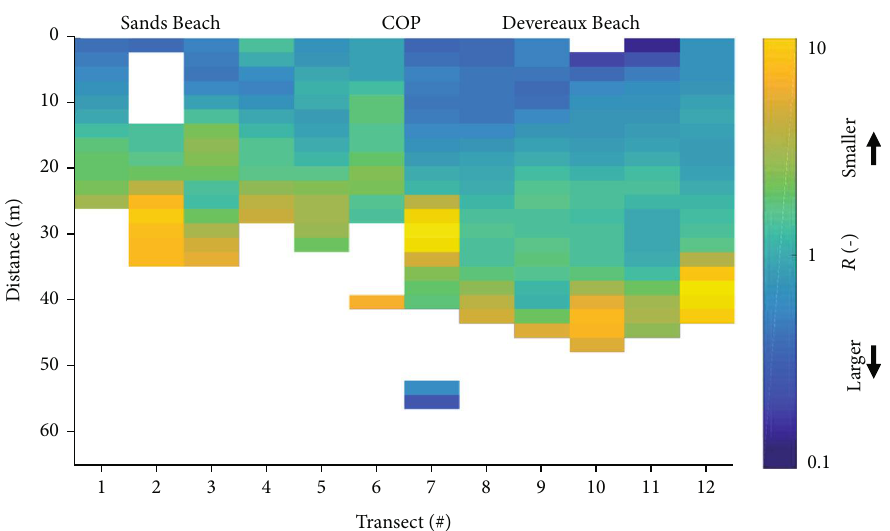
Figure 32: Tar mass accumulation ratio ( R ) of small (classes 1 and 2) to large (classes 3 and 4) tar balls ( R = mass ð 1&2 Þ /mass ð 3&4 Þ ), 2007- 2009 for Coal Oil Point (COP), with respect to distance from the blu ff s and transect. R was 4 m smoothed along the distance axis.